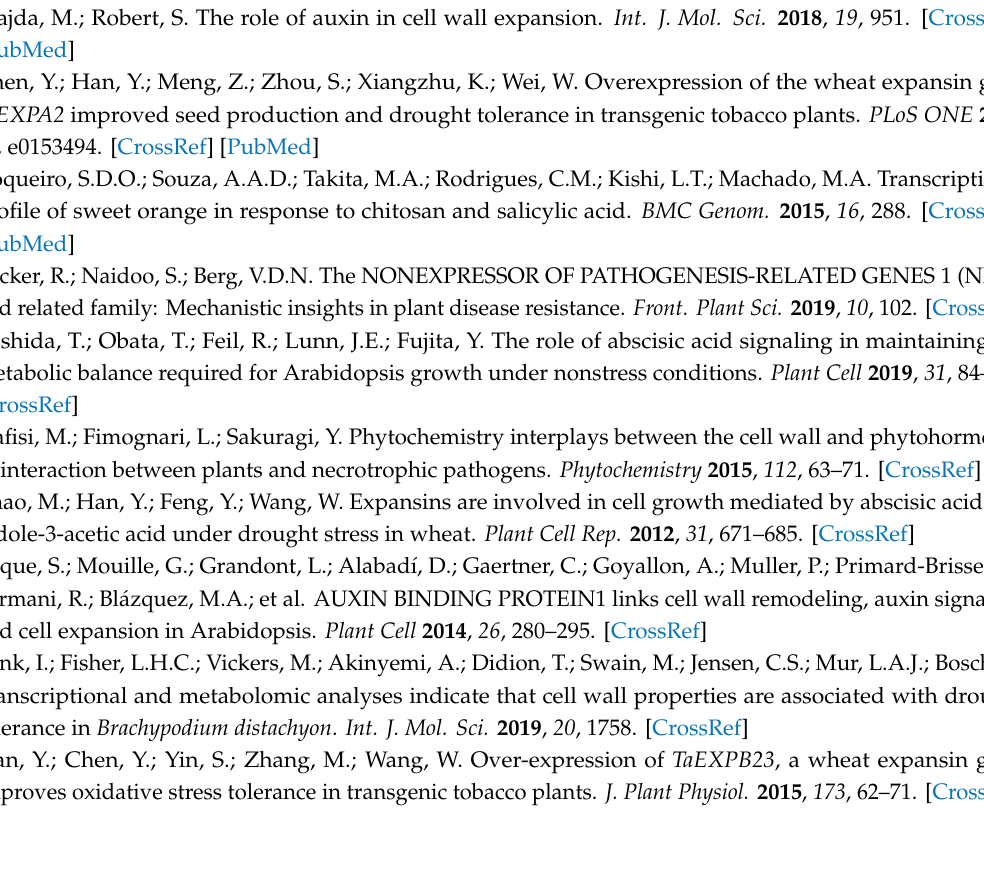
Figure S1: The simplified version of expression cassette used for Agrobacterium-mediated genetic transformation and transgene ( BrEXLB1 ) expression pattern in transgenic Brassica rapa lines; Figure S2: The methodology followed in T-DNA flanking sequencing and the list of primers used in this study for identification of transgene integration site; Figure S3: The BrEXLB1 protein–protein interacting prediction network obtained from String-db tools and the list of primers designed for expression profiling of BrEXLB1 interacting genes; Figure S4: qRT-PCR based relative quantification of lateral root marker genes such as GATA23 and MAKR4 ; Table S1: List of OJIP transient parameters collected from OX, OX-AS lines, and wild type B. rapa lines subjected to 8 days of progressive drought